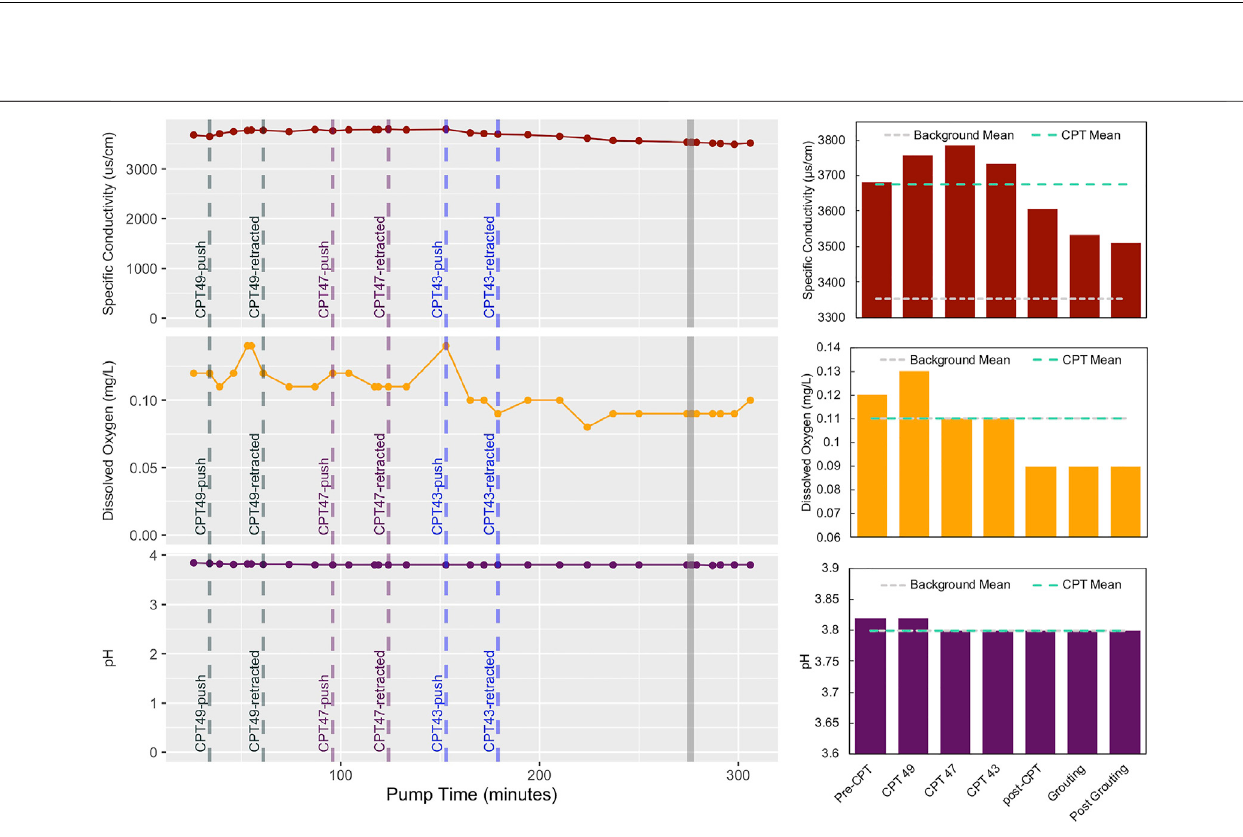
FIGURE 3 | Geochemistry measured in FW115 during local cone penetrometer activity shows geochemistry measurements during and following local cone penetrometer activities. Each of the boreholes were grouted around 270 min (gray line). Mean values for CPT activity are plotted in the bar charts on the right with CPT activity mean in teal and mean non-CPT geochemistry background in ash